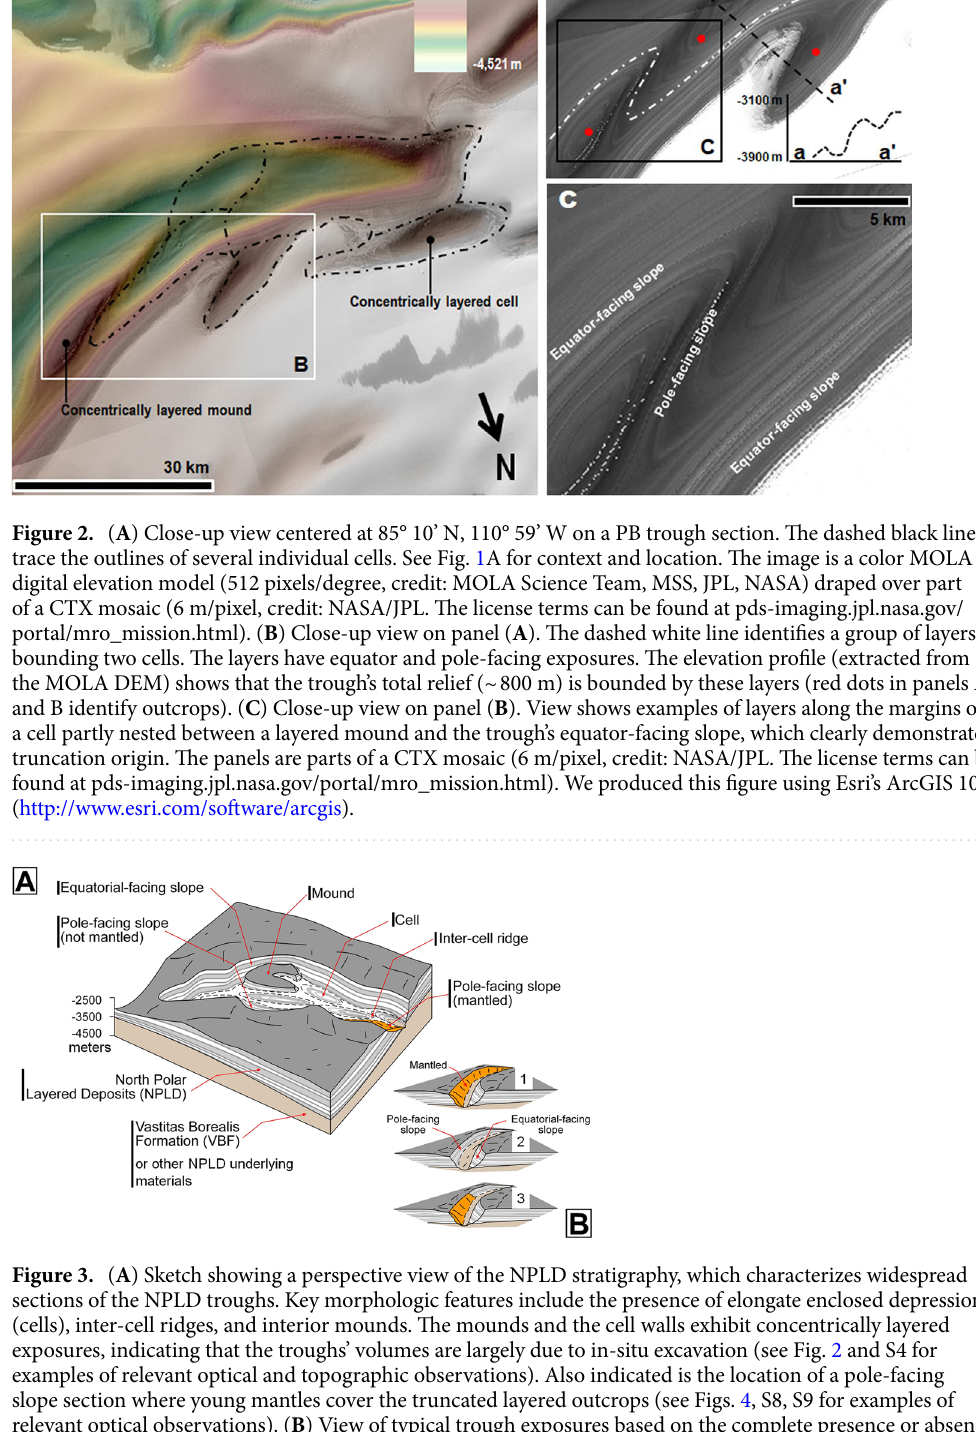
ous spiral arms that are entirely excavated into the NPLD. These arms retain numerous inter-cell ridges and widespread arcuate cell margins. (3) Spiral troughs without significant gaps with floors that exhume surfaces situated beneath the NPLD. These arms retain relatively fewer arcuate cell margins and, in their NPLD excavated segments, exhibit some inter-cell ridges.